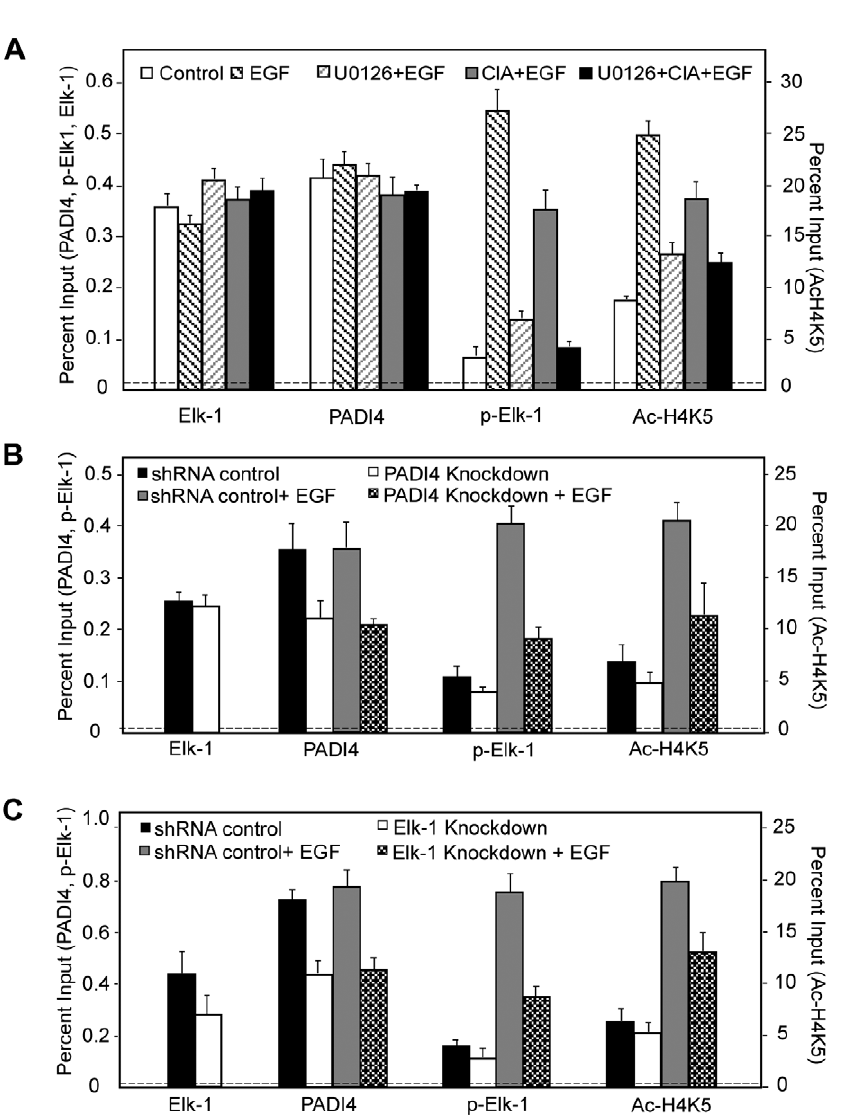
Figure 5. PADI4 enzymatic activity facilitates c-Fos transcription via regulation of Elk-1 phosphorylation and/or HAT-mediated histone acetylation. (A–C) ChIP-qPCR analysis of PADI4, Elk-1, p-Elk-1, and Ac-H4K5 binding at c-Fos promoter in serum-starved or EGF-stimulated MCF-7 cells; (A) in the absence or presence of Cl-Amidine or/and U0126 treatment; (B) with or without PADI4 knockdown; or (C) with or without Elk-1 knockdown. The IgG control in the ChIP assay is indicated by the horizontal dotted line.